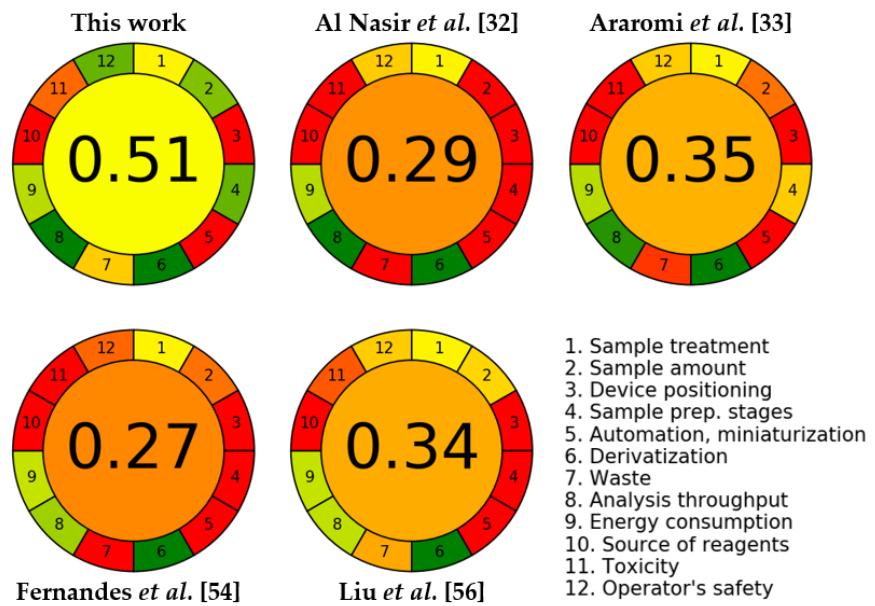
Figure 4. AGREE final score showing the green impact of the proposed protocol towards methods already published in the literature for the analysis of PAHs and PCBs in tomatoes.